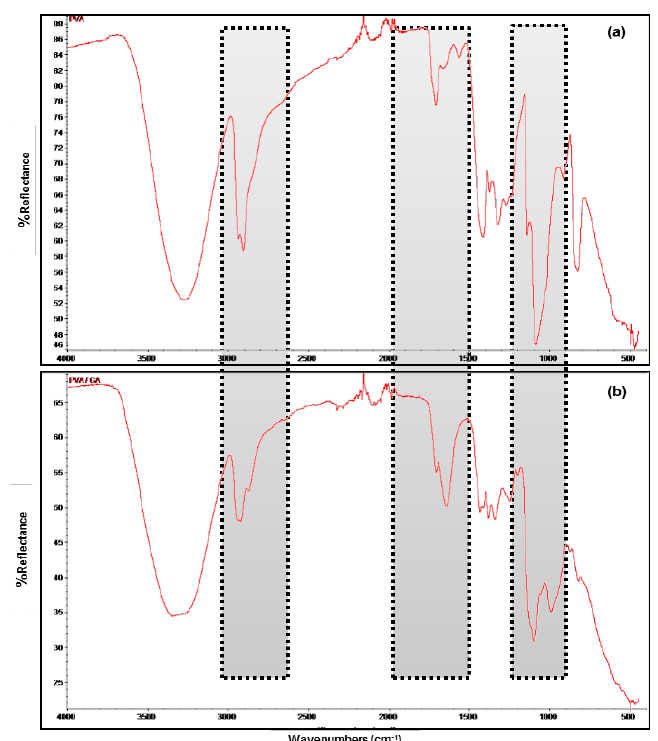
Figure 4. FTIR spectra from: ( a ) pure PVA and ( b ) PVA crosslinked by glutaraldehyde (GA).